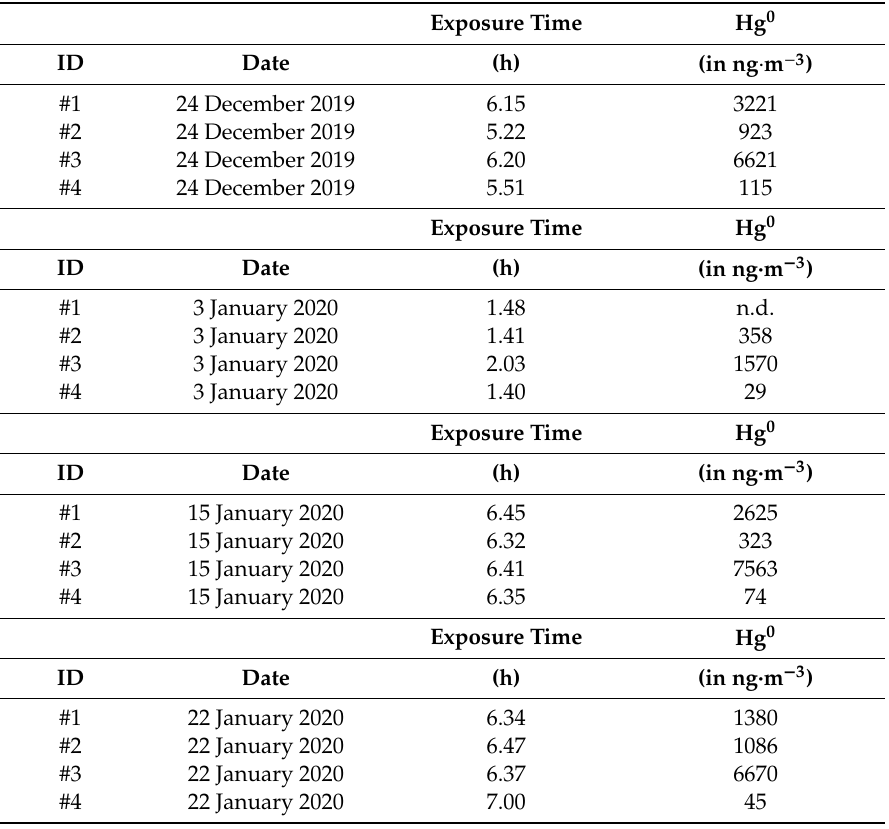
Table2. Concentrationofgaseousmercury(inng · m − 3 )releasedfromthesyntheticmaterials. Theweight of each sample, the date and the exposure time are also reported; n.d.: not